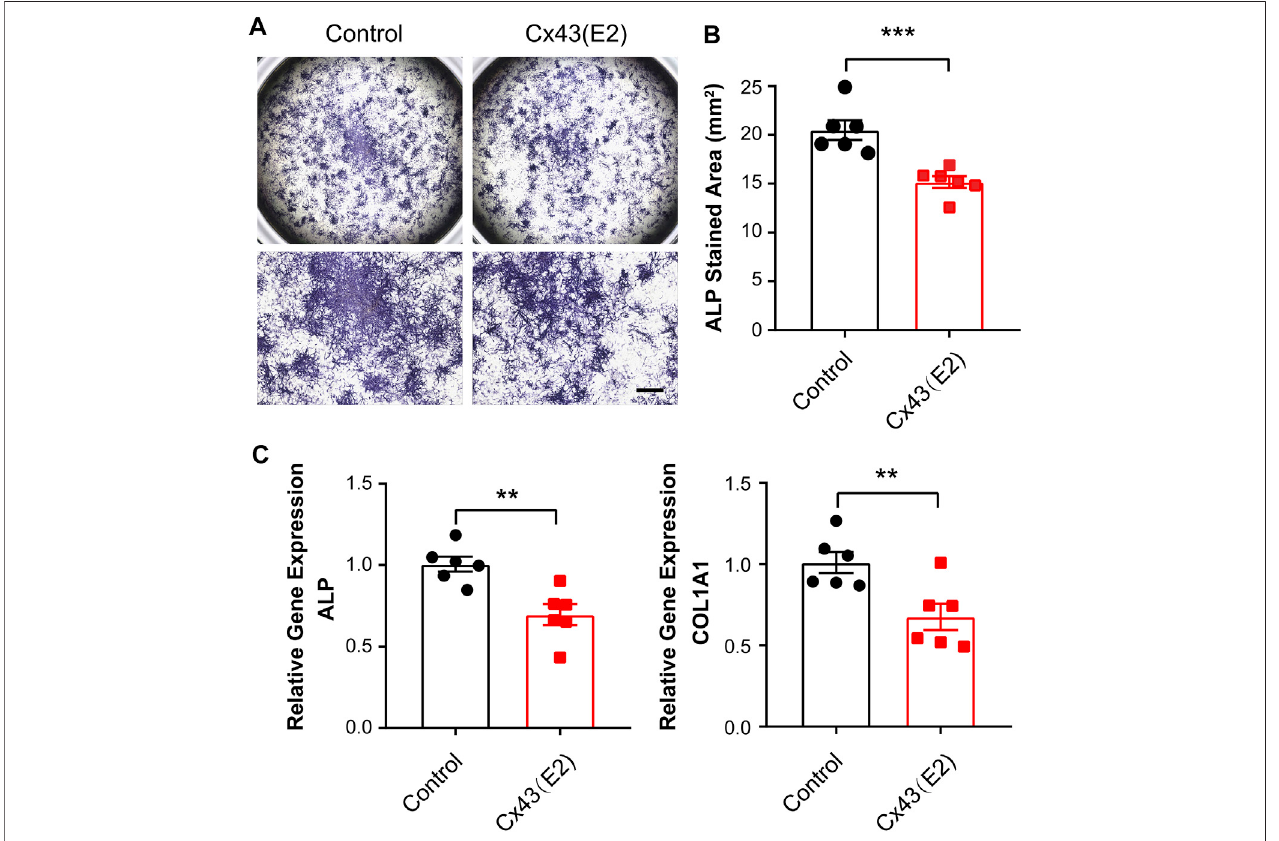
FIGURE 6 | Inhibition of Cx43 hemichannels decreased alkaline phosphatase and type I collagen expression in IDG-SW3 cells. (A) Representative images of ALP staining in control or Cx43 (E2) antibody – treated IDG-SW3 cells at day 9 of the induction of differentiation. Lower panels show enlarged view of the center regions of upper panels. (B) Quanti fi cation of ALP-stained area by NIH ImageJ software. (C) Total RNA was prepared from control or Cx43 (E2) antibody – treated IDG-SW3 cells. The mRNA levels of ALP and COL1A1 were determined by real-time PCR normalized to GAPDH. Data shown are mean ± SEM. **, p < 0.01, ***, p <